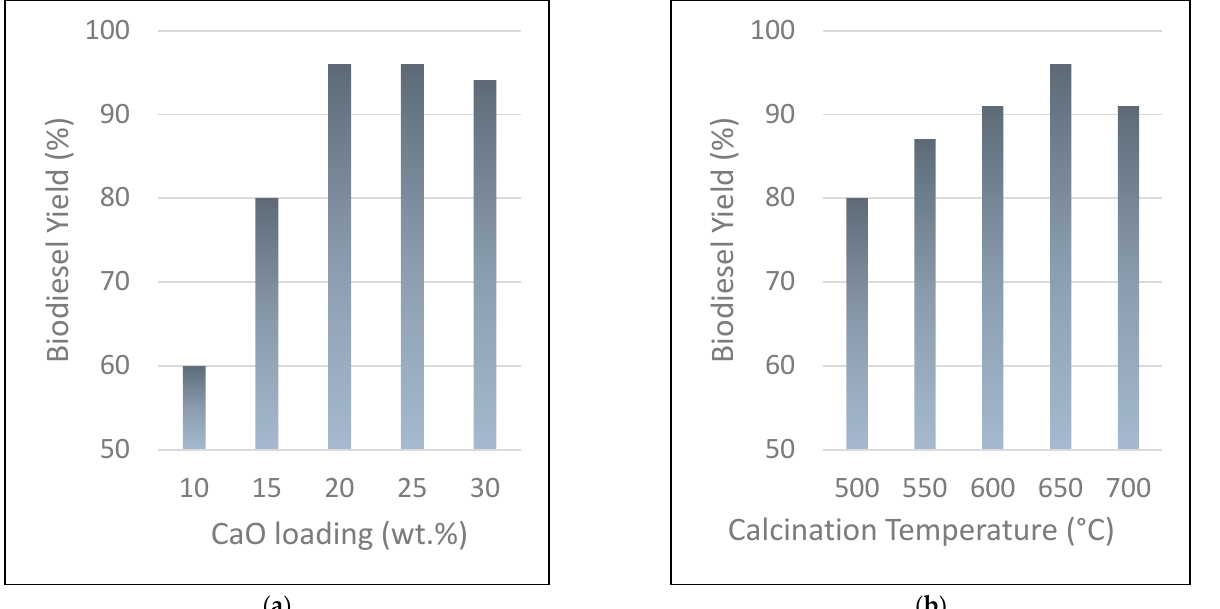
Figure 7. Impact of catalyst preparation conditions on FAME yield ( a ) CaO loading and ( b ) Calcination temperature.